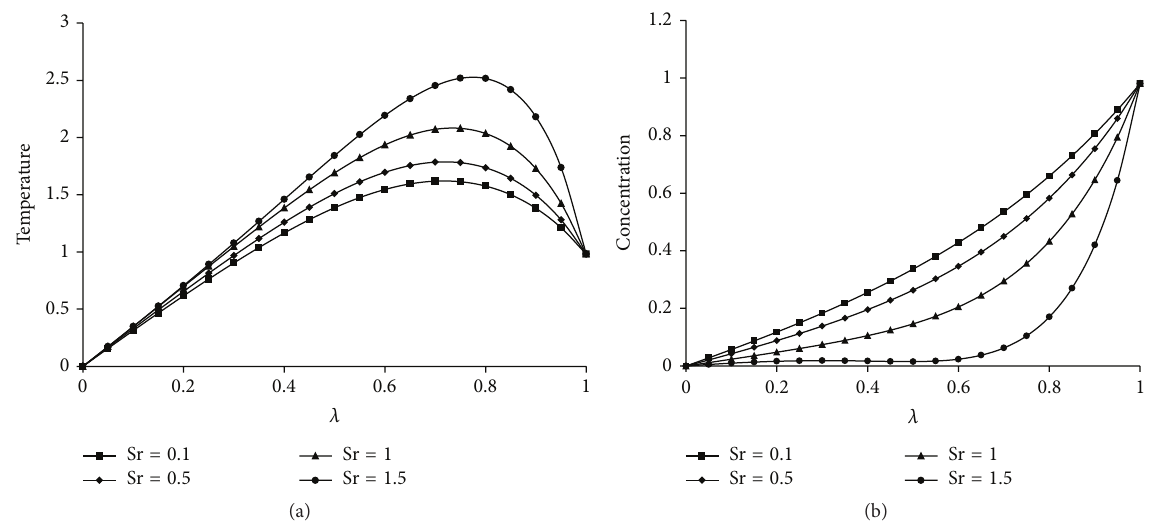
Figure 2: Effect of Sr on (a) temperature and (b) concentration for Kr = 2, Gr = 4, Gm = 4, Re = 2, Du = 2, Sc = 0.22, Pr = 1, 𝑎 = 0.2 , 𝜓 = 0.2 , = 0.2 , 𝑠 = 2 , 𝑠 = 10 , Ha = 1, 𝐷 −1 = 2 , and Ec = 1. 𝑅 = 0.2 , 𝐽 1 1 2